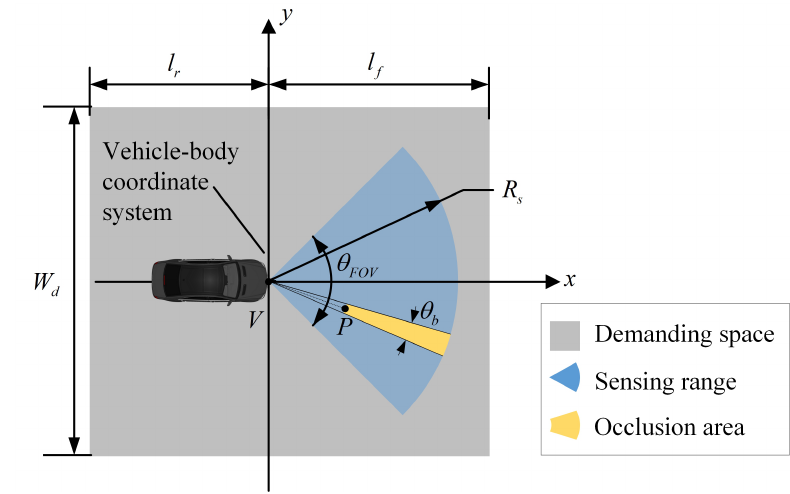
Figure 3. Sensing range and perception